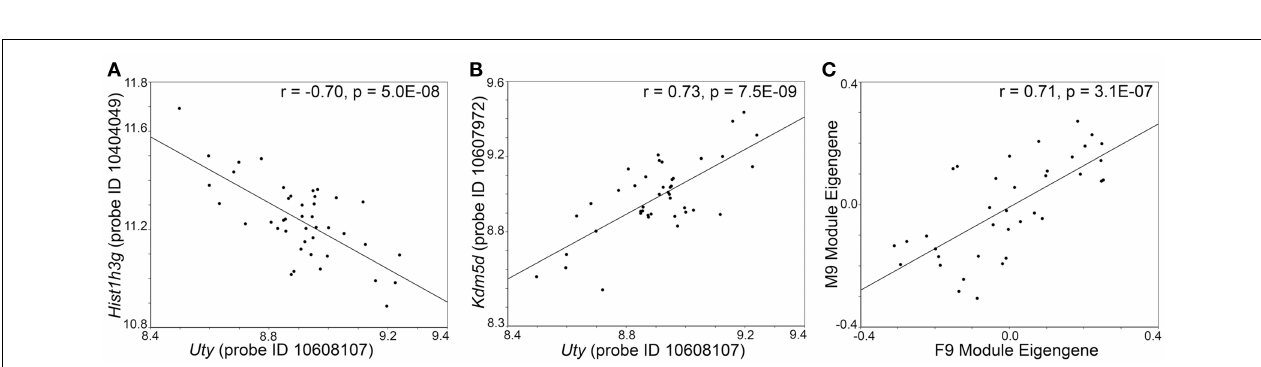
In the corresponding female module, the position of Uty is replaced by the female paralog Kdm6a .The sub-network of F2 shows the top 15 covariates of Kdm6a .Transcripts correlated with both Uty and Kdm6a are highlighted by purple ovals.